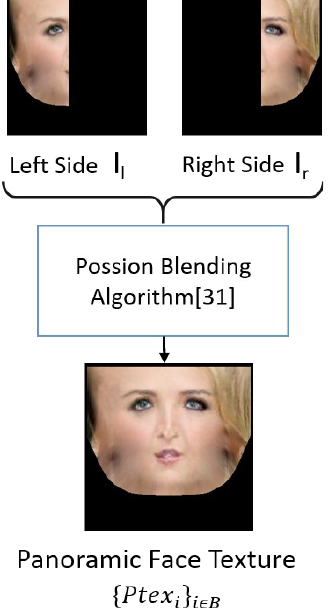
Figure 7. Panoramic texture blending method.